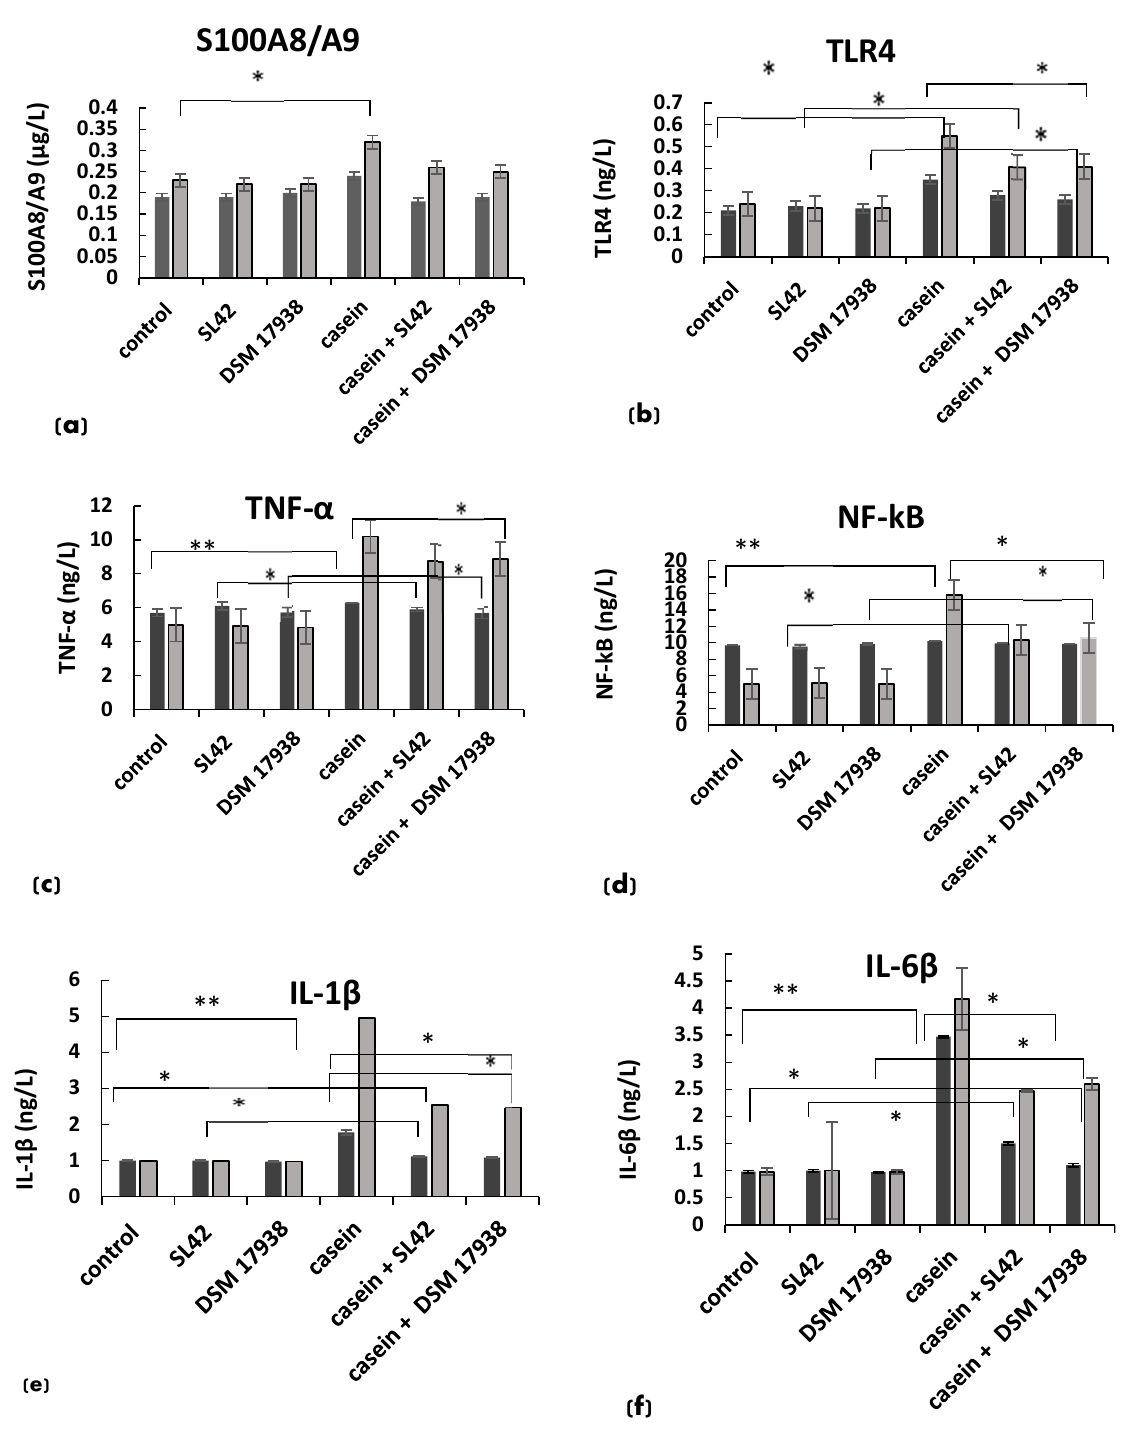
Figure 4. The expression of S100A8/A9 and associated cytokines in Wistar rats sensitized intragastrically by administration of casein without adjuvant (before 1st day, after 58th day). S100A8/A9 ( a ), TLR4 ( b ), TNF- α ( c ), NF- κ B ( d ), IL-1 β ( e ), and IL-6 ( f ) levels in sera of rats from different groups are shown. Values are means ± SEM (n = 8 rats/group). * p < 0.05. ** p < 0.01. Control group receiving only PBS (control group), nonsensitized group treated with SL42 strain (SL42 group), nonsensitized group treated with DSM 17938 strain (DSM 17938 group), casein-sensitized group (casein group), casein-sensitized group treated with SL42 (casein + SL42 group), and casein-sensitized group treated with DSM 17938 strain (casein- + DSM 17938 group).